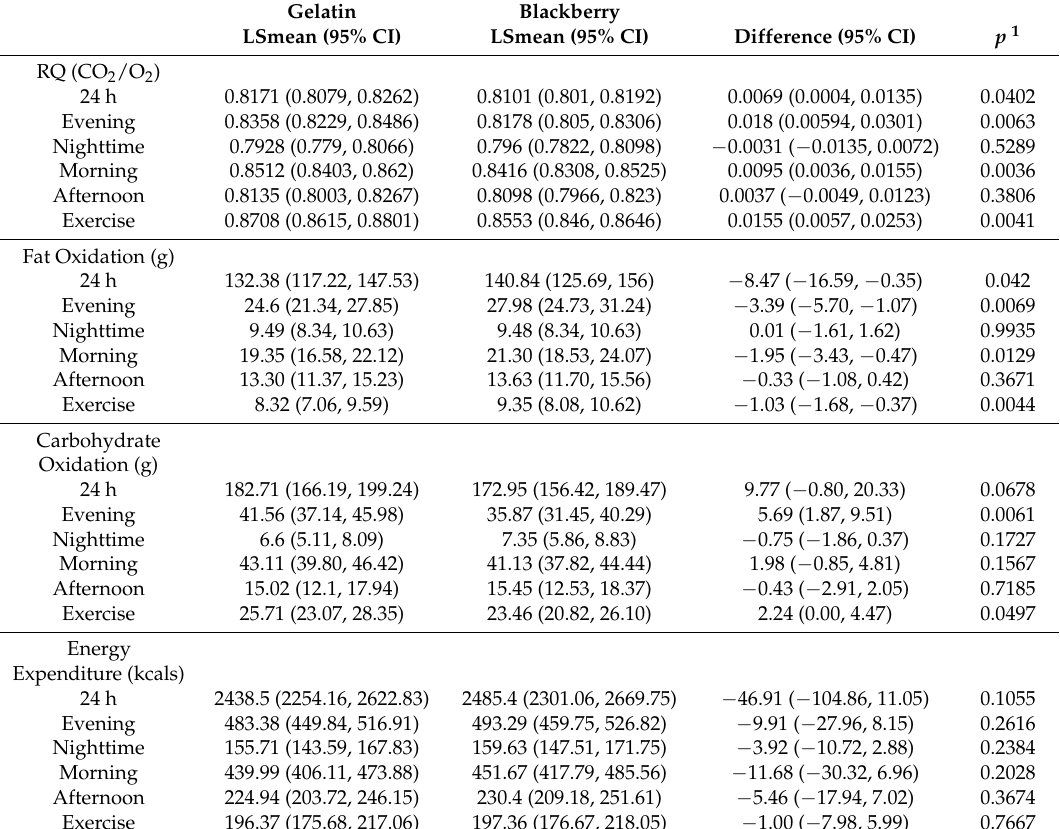
Table 4. Respiratory quotient, energy expenditure, and substrate oxidation after consumption of blackberries or gelatin for 7